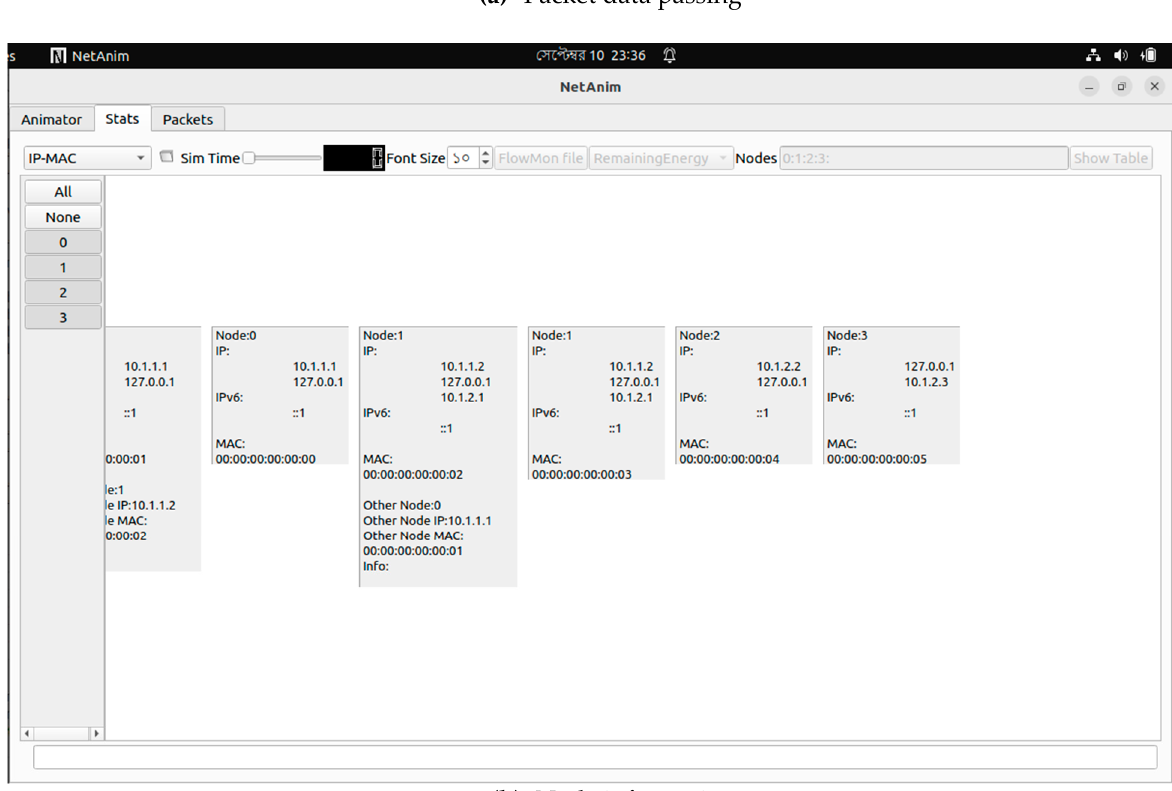
Figure 12. NS3 simulation from HMS to FTP and IoT. (a)Packet data passing; (b)Node information.